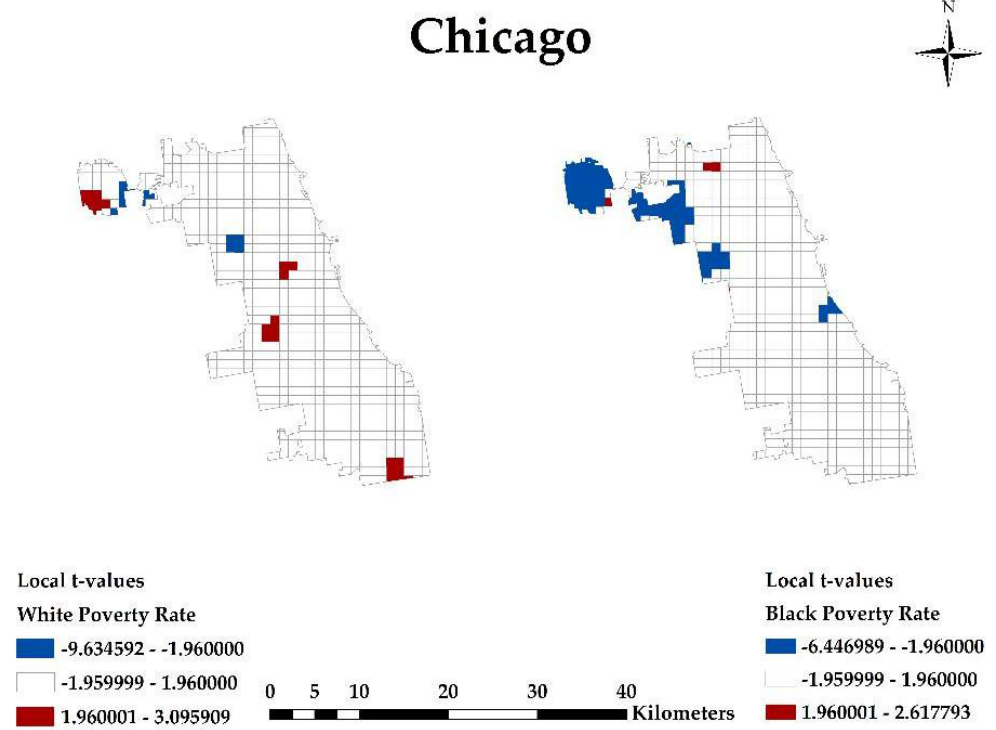
Figure 7. Chicago shrinking city White Poverty Rate and Black Poverty Rate: 95% two-tailed test (−1.96:1.96).